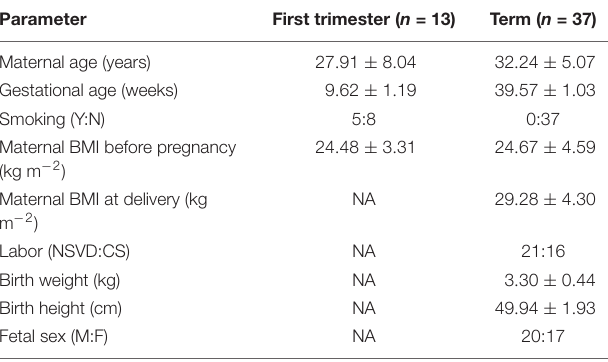
TABLE 1 | Clinical characteristics of first-trimester and term pregnancies involved in the study.